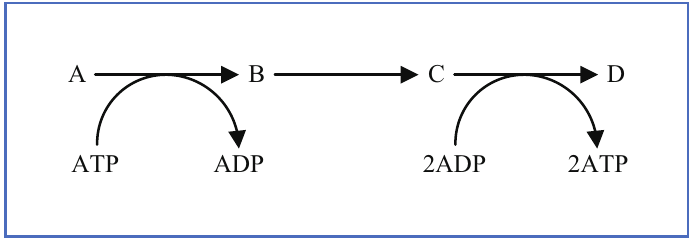
Figure 5. ATP, 2ATP, ADP, and 2ADP appear in the same metabolic